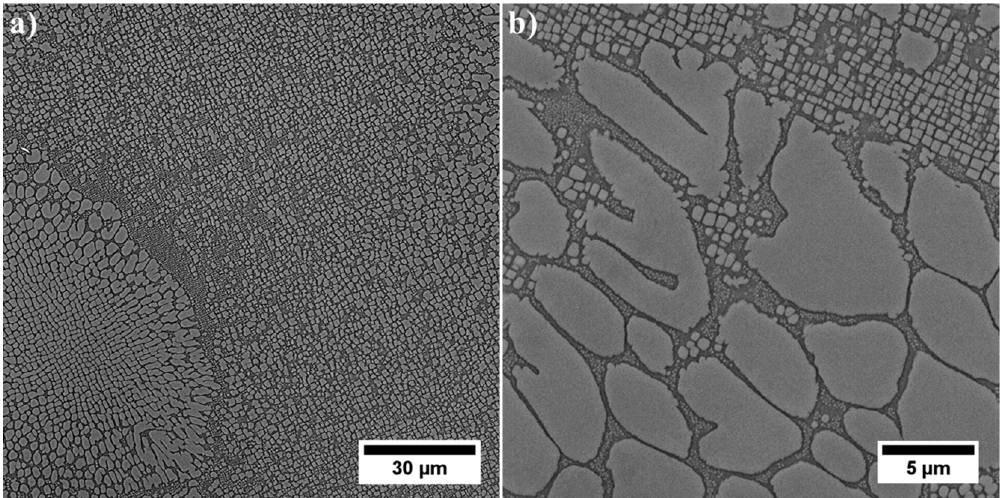
Figure 5. ( a ) the γ (cid:48) mean radius distribution; ( b ) shape coe ffi cient ζ distribution. Figure 5. a ) the γ ' mean radius distribution; b ) shape coefficient ζ distribution.